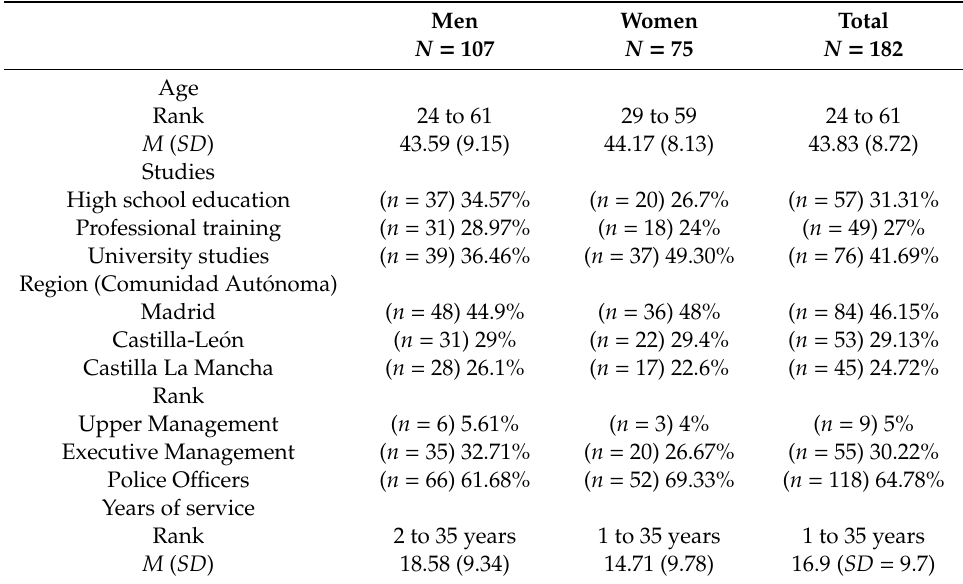
Table 1. Sociodemographic data of the sample regarding gender. Men N =